Question: State the chart type depicted above.
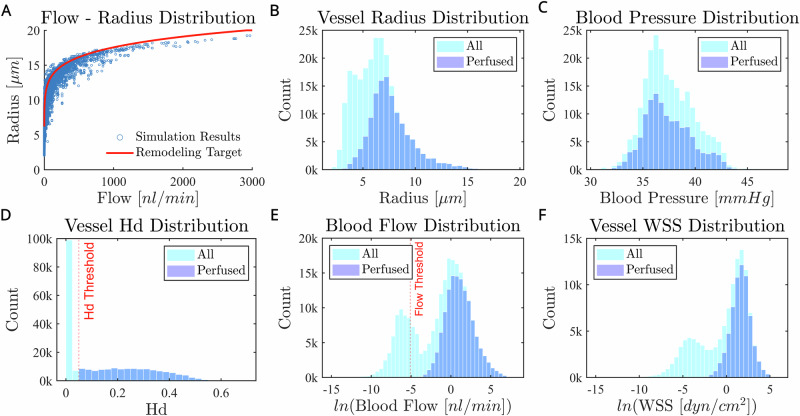
Answer: scatter